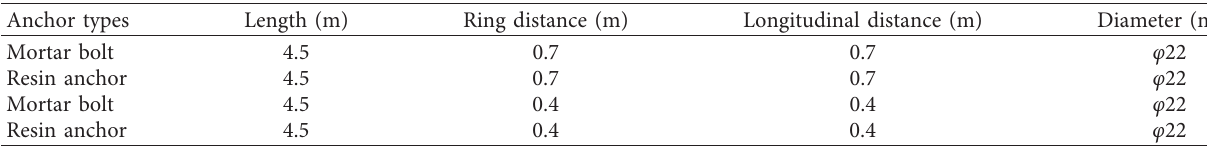
Table 4: Encrypted bolt support parameters.